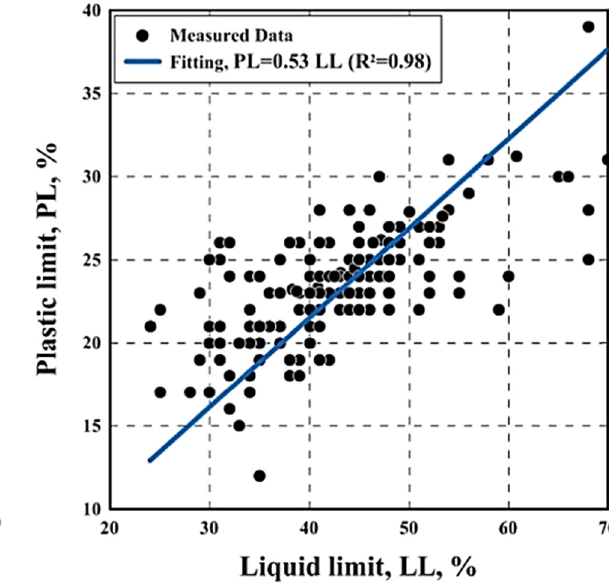
Figure 10: Void ratio versus water content relationship.